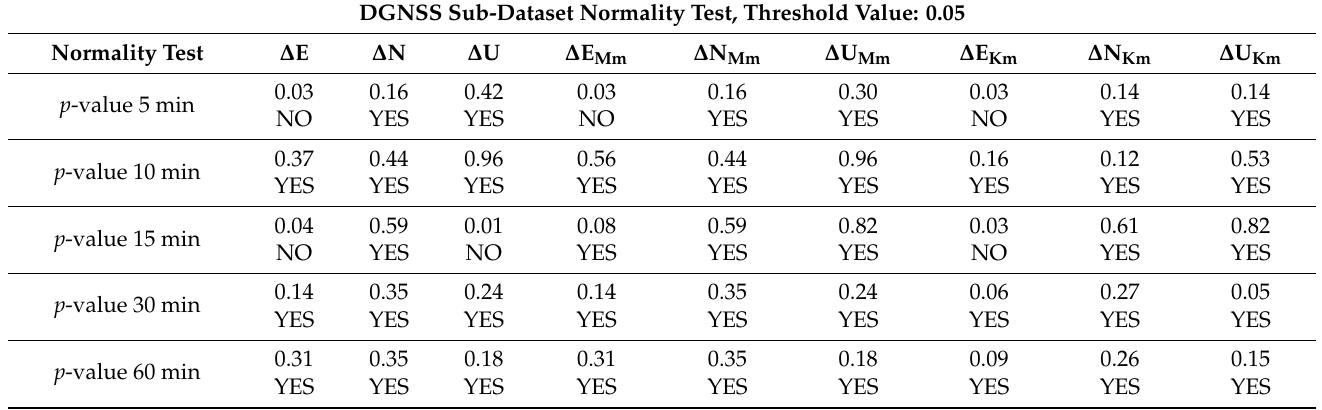
Table 3. Normality test for DGNSS positioning error.